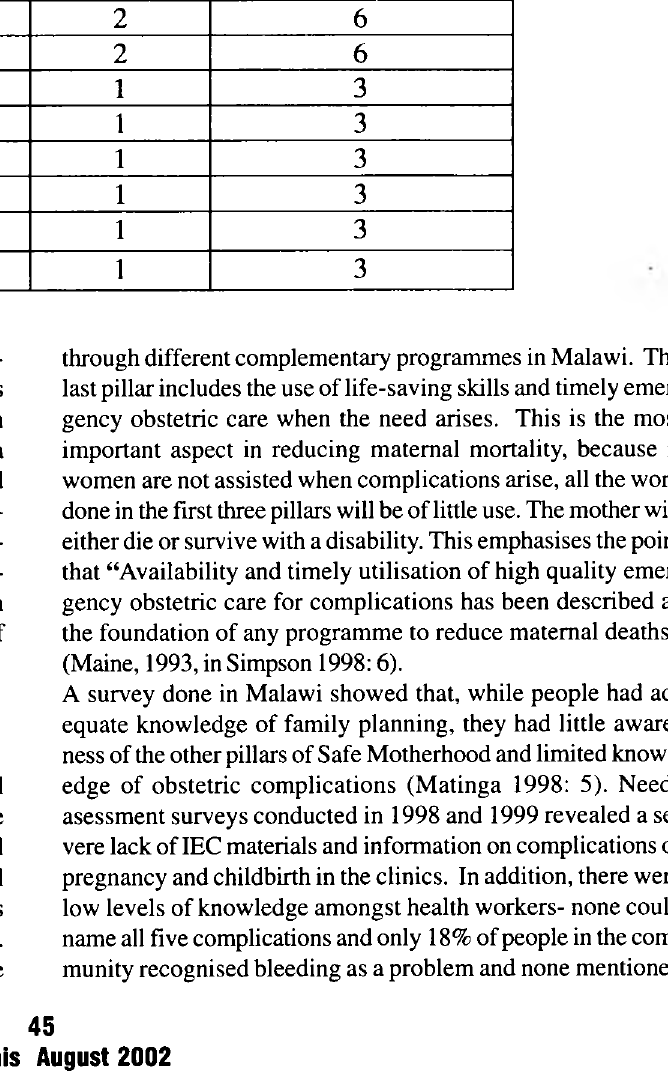
Table 2 : Problems that may occur during pregnancy (n=33) PROBLEM n PERCENTAGE Vaginal bleeding